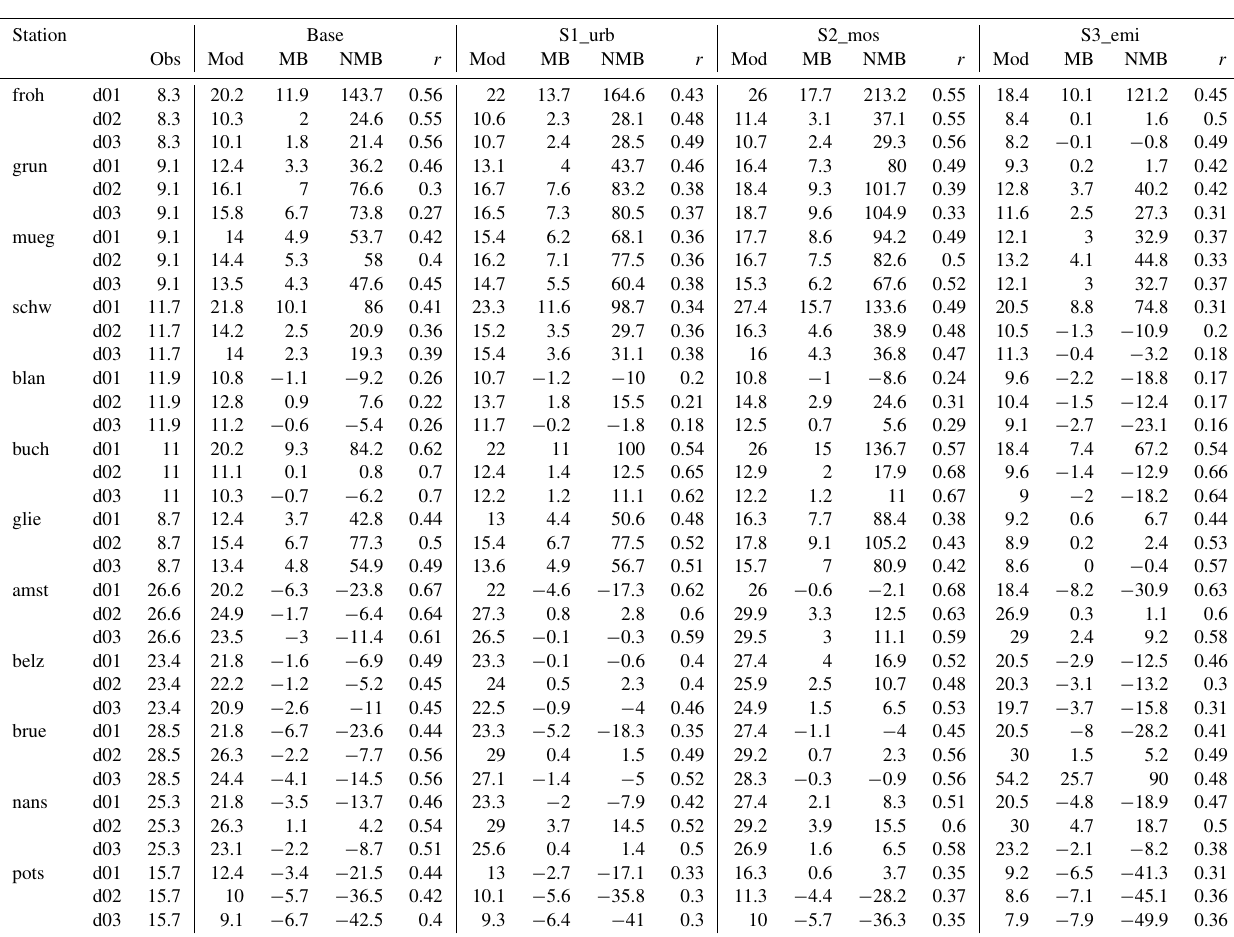
Table 7. Statistics of daily NO x for JJA. “Obs” refers to the JJA observed mean, “mod” refers to the JJA modelled mean for the respective grid cell. MB is the mean bias for JJA, NMB refers to the normalised mean bias and r is the correlation of hourly values. Obs, Mod and MB are given in µgm − 3 and NMB is given in %. The statistics are shown for the results from the model domains of 15km (d01), 3km (d02) and 1km (d03) horizontal